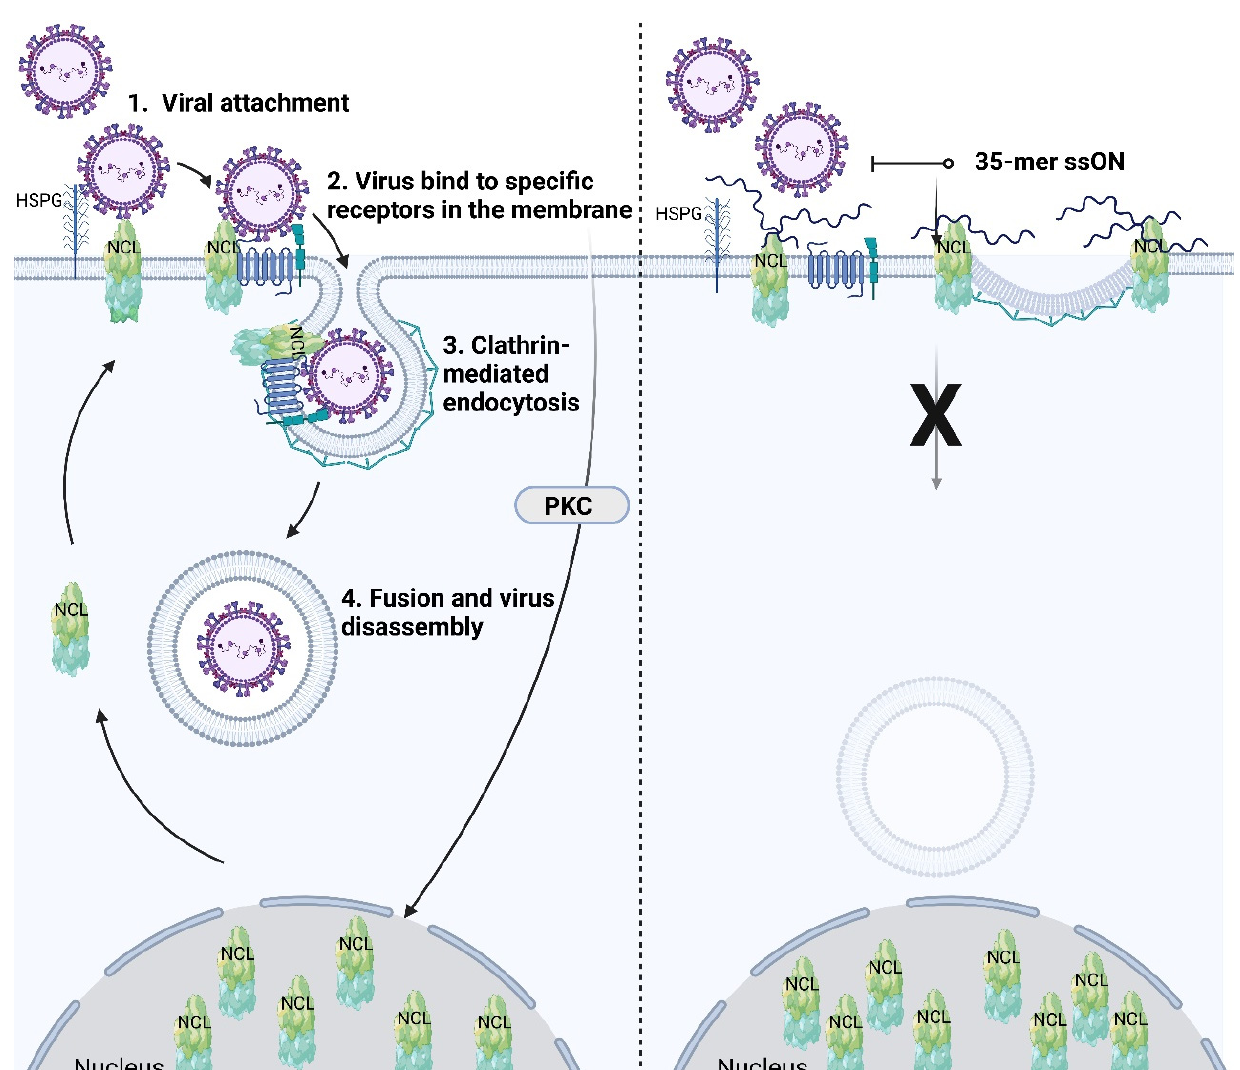
Figure 3. Schematic illustration of nucleolin (NCL) as an attachment receptor for virus and participation in clathrin-mediated endocytosis ( left ), which can be inhibited by 35-mer ssON ( right ). Initially, certain viruses attach to the cellular membrane using heparan sulfate proteoglycan (HSPG) and/or NCL. Next, viruses bind to specific receptors involved in viral entry, and may also trigger intracellular signaling. Hence, viral glycoproteins, such as the RSV F-protein, binds to cellular receptors (IGF1R for RSV) which initiates signaling (PKC ζ for IGF1R) [120]. The signaling leads to translocation of NCL from the nucleus to the cell surface. Cell surface NCL also interacts with the C-terminal residues of clathrin light chain A, which is a key component in clathrin-dependent endocytosis. Upon specific receptor binding, the viral entry process is initiated and often occurs through clathrin-mediated endocytosis. Subsequently, viral fusion and virus disassembly may occur. Nucleolin regulates viral attachment and binds nucleic acids as well as aptamer AS1411 through binding of the C-terminal glycine/arginine-rich domain (yellow-green). However, viral proteins (such as RSV F-protein) may also interact with NCL RBD for internalization [113]. The 35-mer ssON but not 15-mer ssON can inhibit viral attachment by shielding NCL [3,4]. We hypothesize that the 35-mer ssONs confer steric hindrance for the endocytosis to occur, while the shorter ssONs are unable to block the molecular movements and are instead readily taken up via clathrin-mediated endocytosis. Created with BioRender.com.